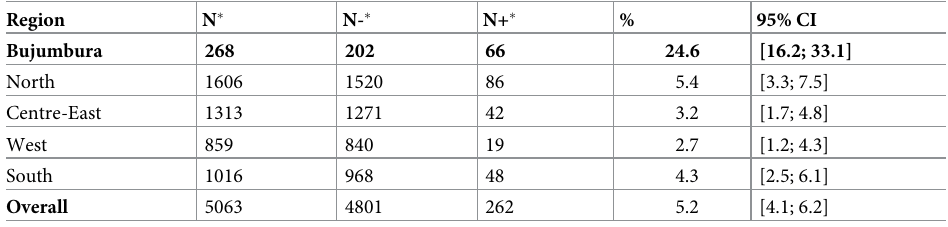
Table 1. Distribution of the ANC prevalence by